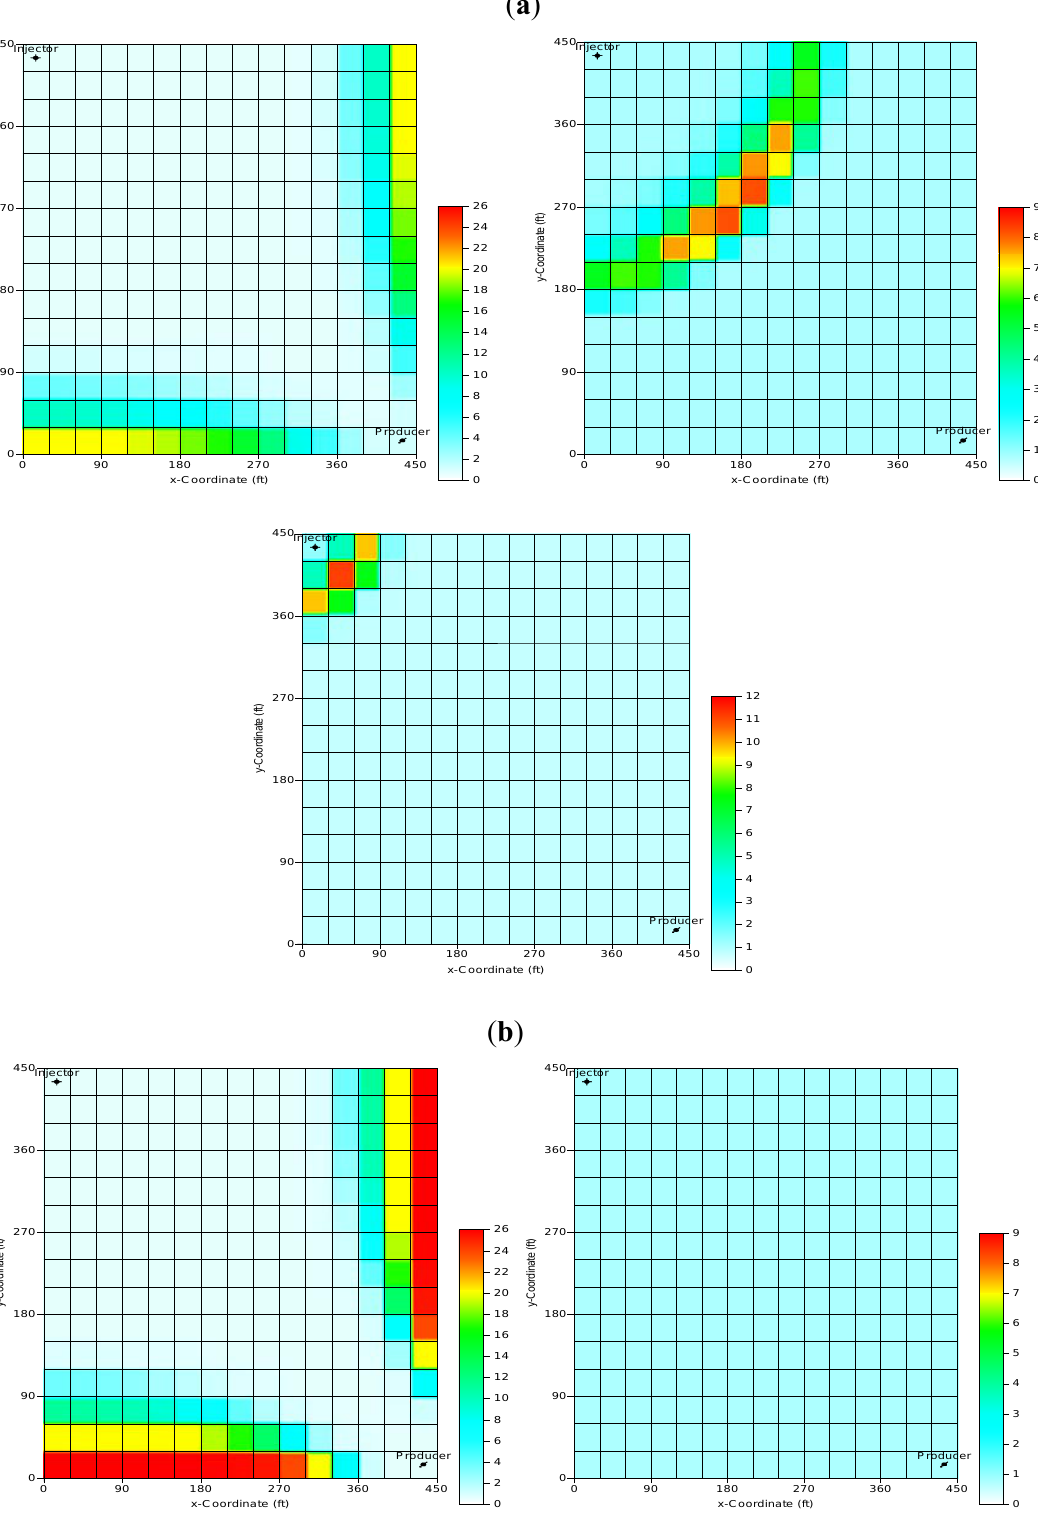
P . ( a ) 0.1 = P ; ( b ) 6.2 = P . α α α ( a